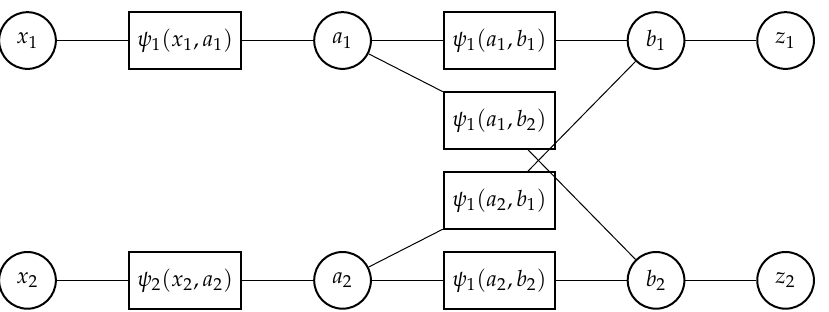
Figure 2. Factor graph representing the factorization of the joint posterior probability density function (PDF) f ( x 1 , x 2 , a 1 , a 2 , b 1 , b 2 | z 1 , z 2 ) according to Equation (41), depicted for one time step. For simplicity, the time index k is